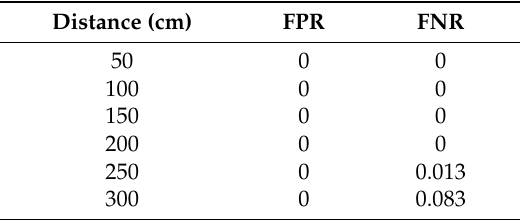
Table 5. Performance of QR code detection